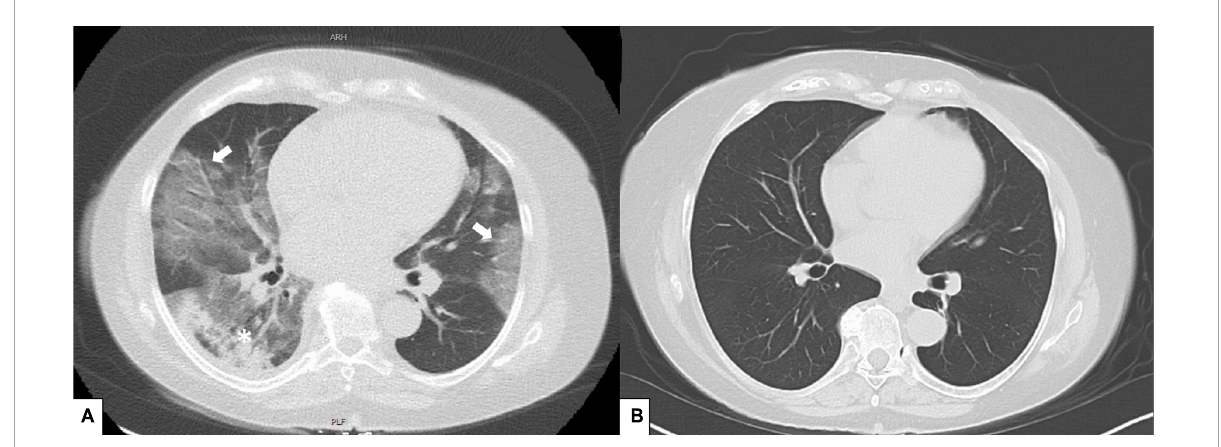
FIGURE1 (A) Computed tomography scans with typical ground glass opacities (white arrows) and consolidation (asterix) predominantly on posterobasal regions, (B) control thorax tomography after 5